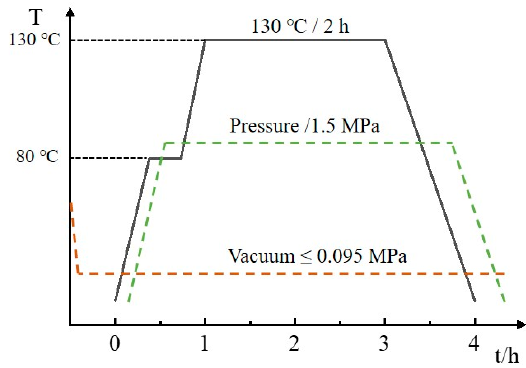
Figure 2. Autoclave molding process parameters.